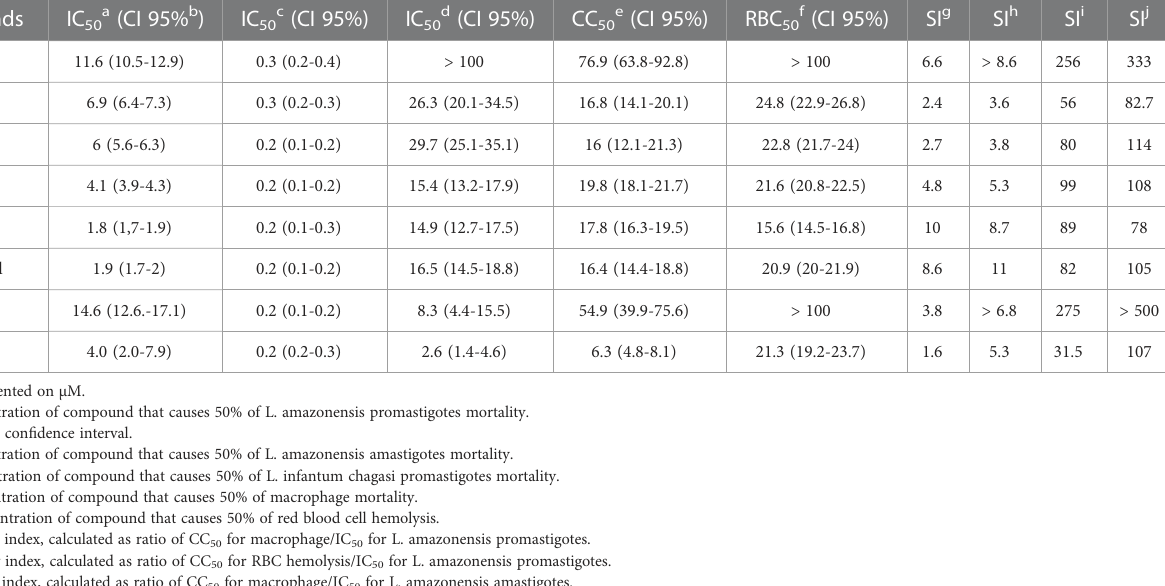
(Figure S38B: Leishmanicidal activity of imidazolium salts, C 16 Im and C 16 PyrCl (0.1 to 100 m M) on promastigote forms of L. infantum chagasi , determined at 48 h incubation using MTT assay), the IC 50 values were in general higher than against L. amazonensis (Table 1).